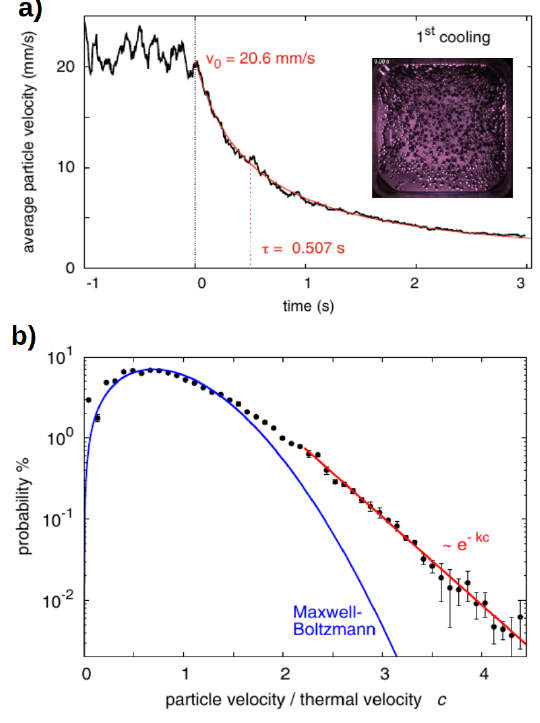
Figure 3. a) The velocity decay of the 1st experiment fitted by Ha ff ’s law. Inset: snapshot taken at 9s after the cooling starts, showing clusters at the top border of the sample cell. b) Velocity distribution of all four experiments during 1.8-3 s after the start of the coolings. Figures are adapted from Ref. [16].